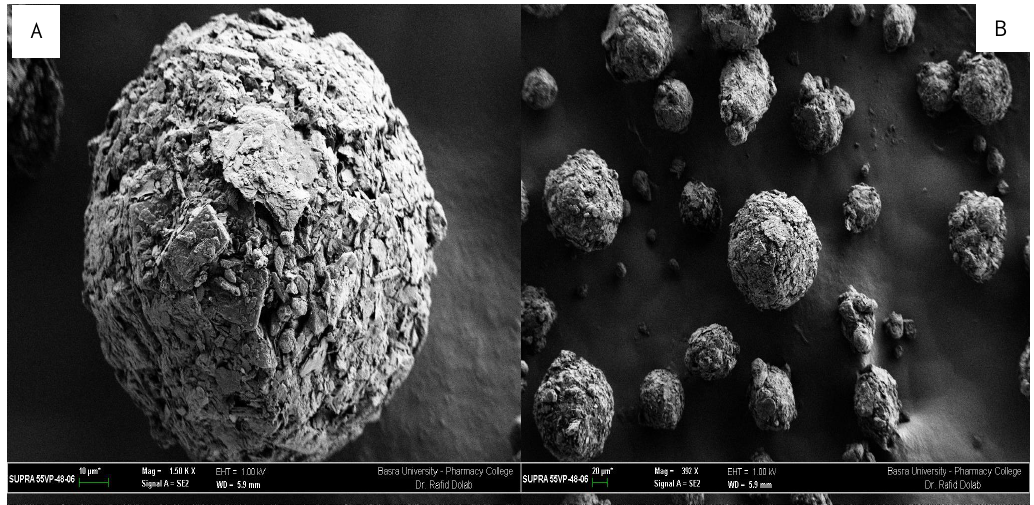
Figure 2. SEM of microsponge F2 [A] 1.5KX magnification [B] 1.0KX magnification Solid state characterization of microsponge